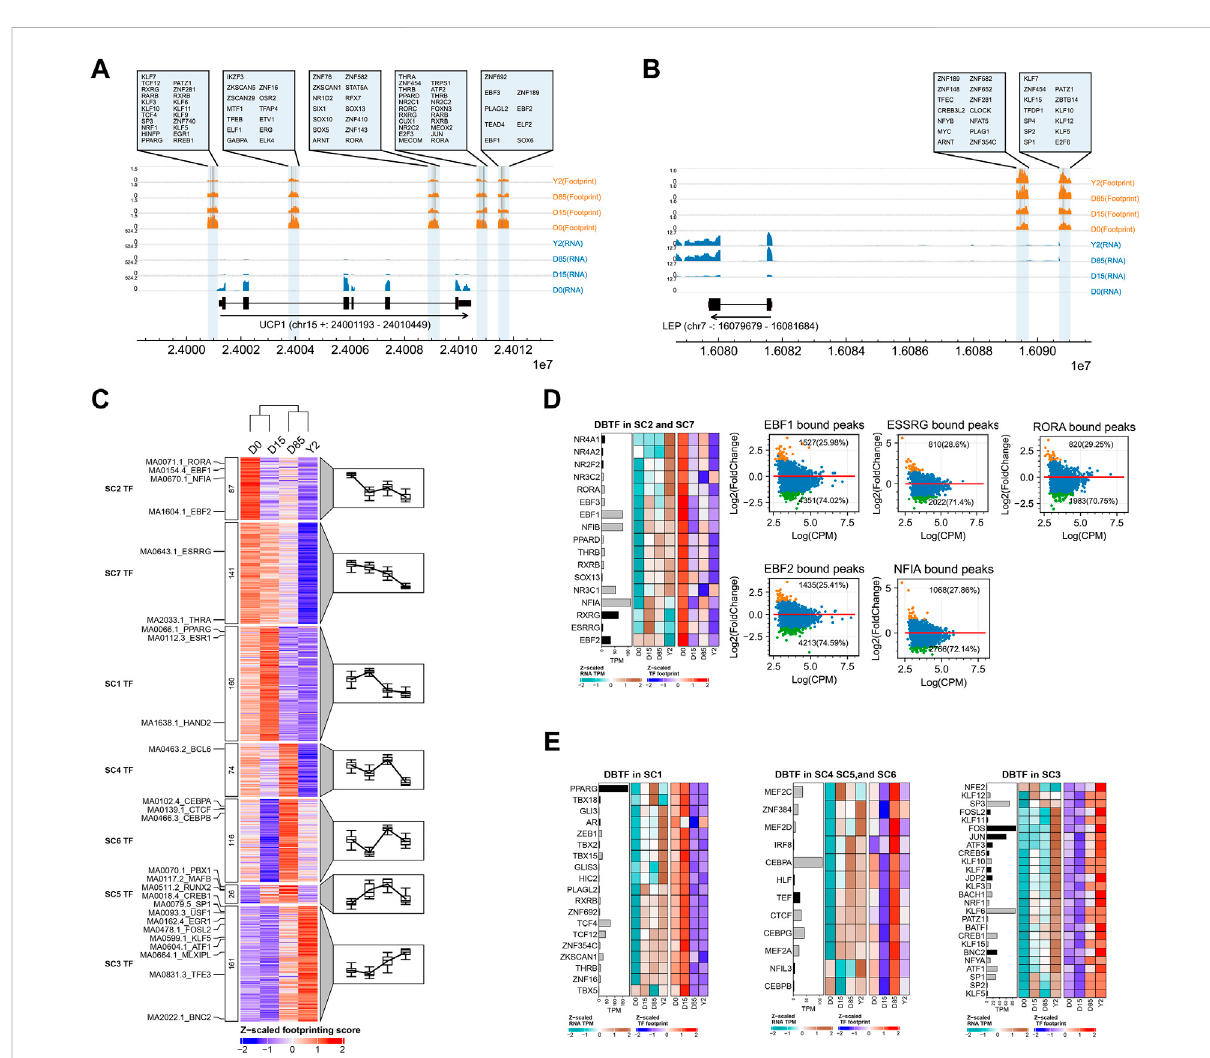
FIGURE 4 Genome-wide TF footprinting analysis during BAT whitening in rabbits. (A,B) The TF footprints at the loci of UCP1 and LEP . The arrows showed the gene transcription directions. The blue and orange tracks showed read coverages of RNA-seq and footprint binding score of ATAC-seq. The bound TFs in highlightedregions were shown in thezoomed axes. (C) Clustering of TF based on footprint score. Each row represents 1 TF,and each columnrepresentsaBATwhiteningstage.TFfootprintbindingscoresareZ-scaledbyrow.Theblueandredcolorindicatesthelowandthehigh footprint score, respectively. Each cluster is associated with a mean trend line (left to right) and timepoint-speci fi c boxplots respectively. (D) Integrative analysis of gene expression and footprint of TFs in SC2 and SC7. The bar plot showing the mean TPM of TF genes and the black bar showing the DEGs. The left and right panels of heatmap showing the expression pro fi les and footprint score of TFs across the four stages, respectively. The MA plots showing the chromatin accessibility changes (from D0 to D15) of target regions of corresponding TFs, with annotation of the number of increased or decreased peaks. (E) Integrative analysis of gene expression and footprint of TFs in SC1, SC4, SC5, SC6, and SC3. The bar plotshowingthemeanTPMofTFgenesandtheblackbarshowingtheDEGs.Theleftandrightpanelofheatmapshowingtheexpressionpro fi lesand footprint score of TFs across the four